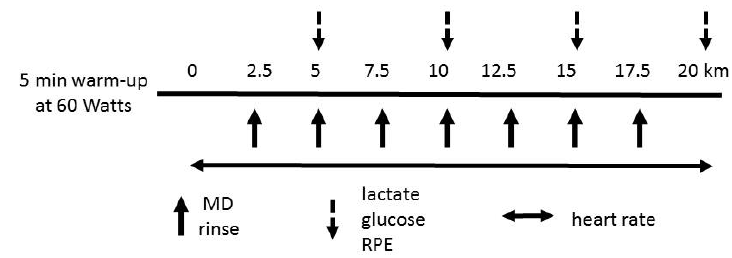
Figure 1. Outline of tests and testing procedures. MD: maltodextrin, RPE: rating of perceived exertion.